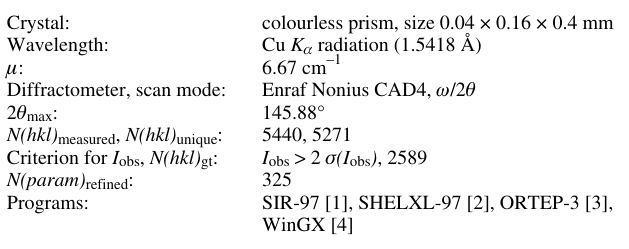
Table 1. Data collection and handling.